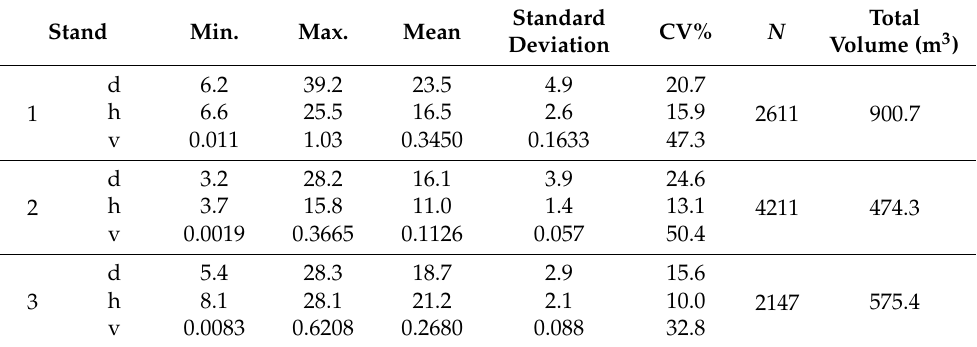
Table 3. Statistics of forest variables by census